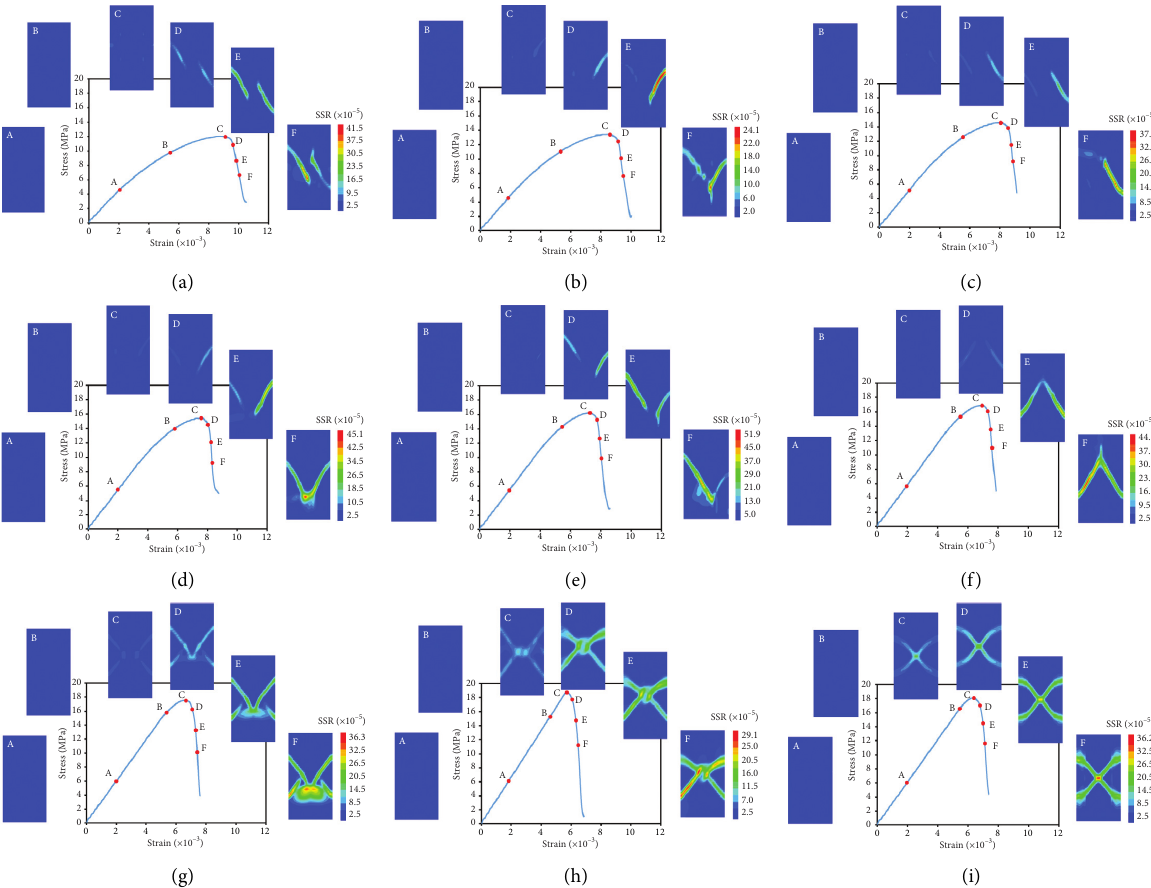
Figure 11: Eight groups of stress-strain curves of coal specimen with nonuniform cohesion assignment by Weibull probability